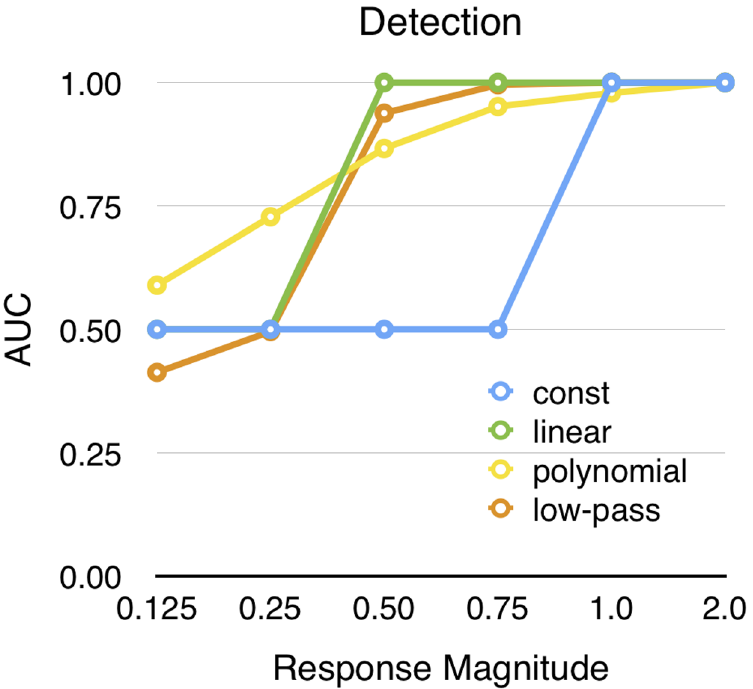
Fig 7. Detection of surrogate data. The area under the ROC-curve was used as an indicator of performance, when the response magnitude was